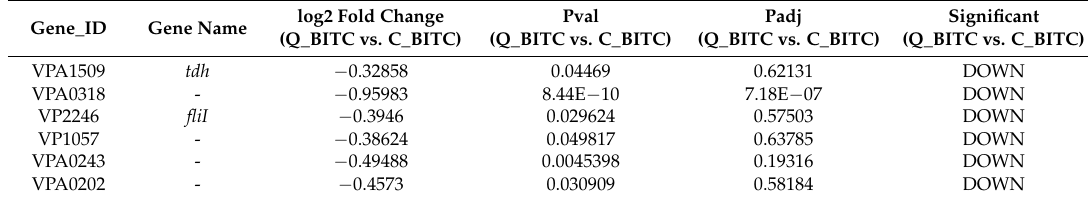
Table 3. Data of the differentially expressed genes.